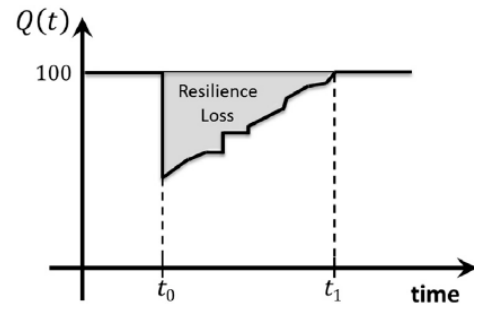
Figure 1. Resilience loss measurement [15].